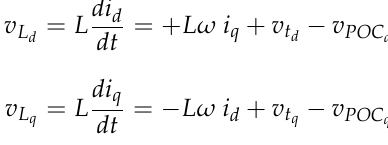
Figure 10. Simplified representation of a grid-connected power converter.